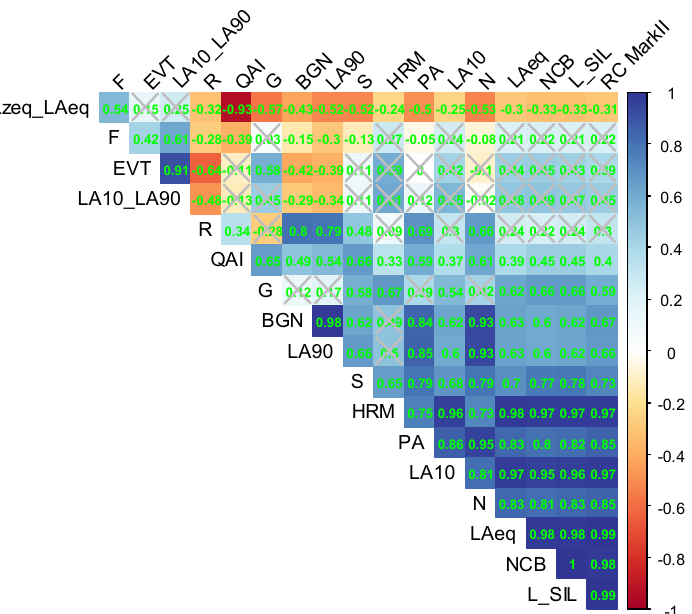
Figure 6. Pearson’s correlation matrix of the noise metrics. Cells with × correspond to the non ‐ significant r ‐ value at the 95% confidence level.